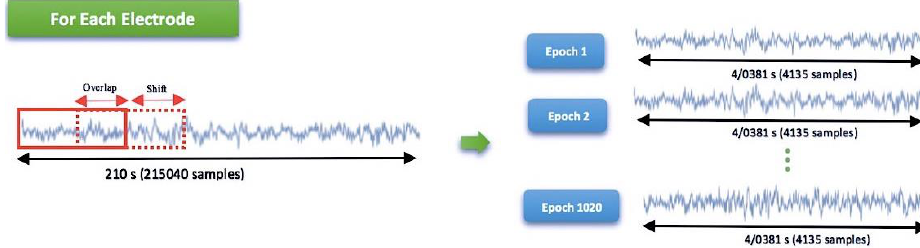
Figure 4. The overlap operation for each electrode.